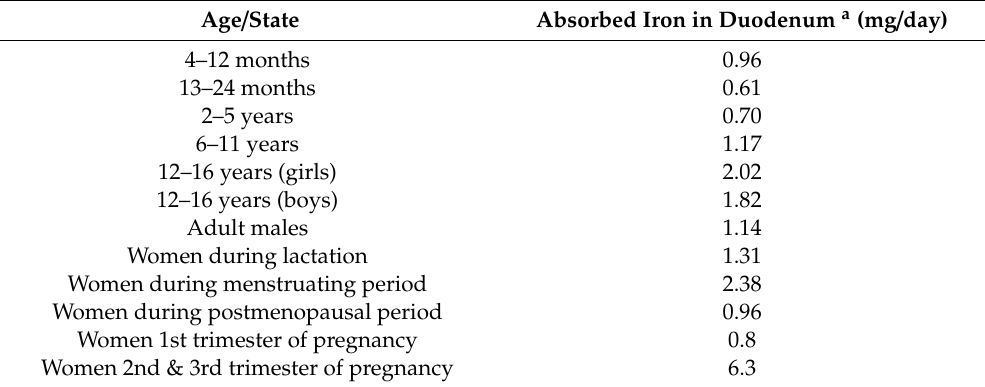
Table 1. Daily requirements of absorbed iron in individuals of di ff erent age, sex and state